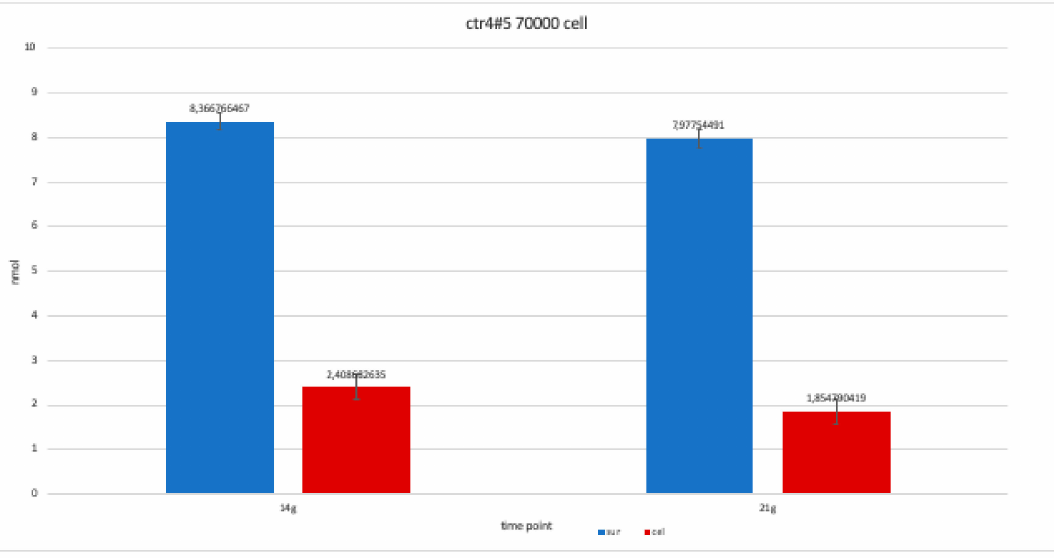
Figure 14. For clone CTR4#5 P20, we only performed two alkaline phosphatases test at 14 and 21 days, since the availability of the number of cells was limited. The trend results are